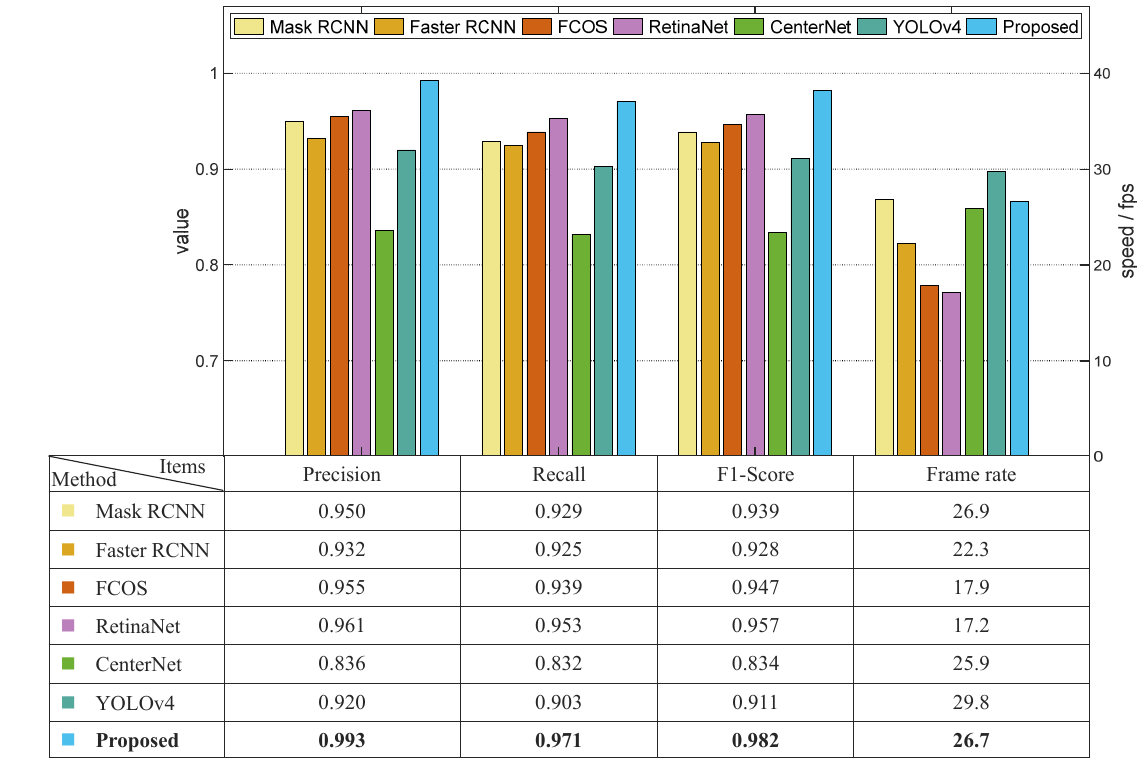
Figure 8. Results of comparison experiment using dataset D.